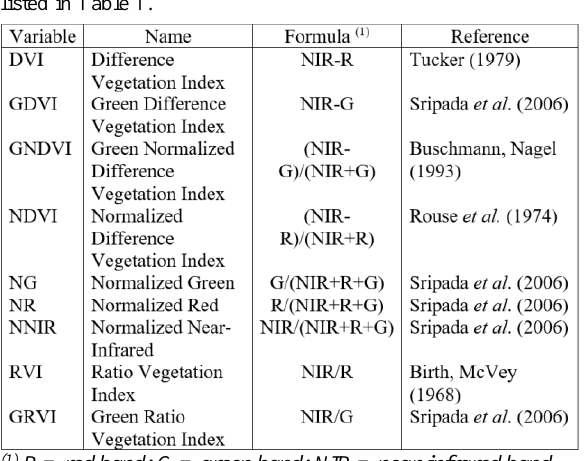
Vegetation indices used in this study